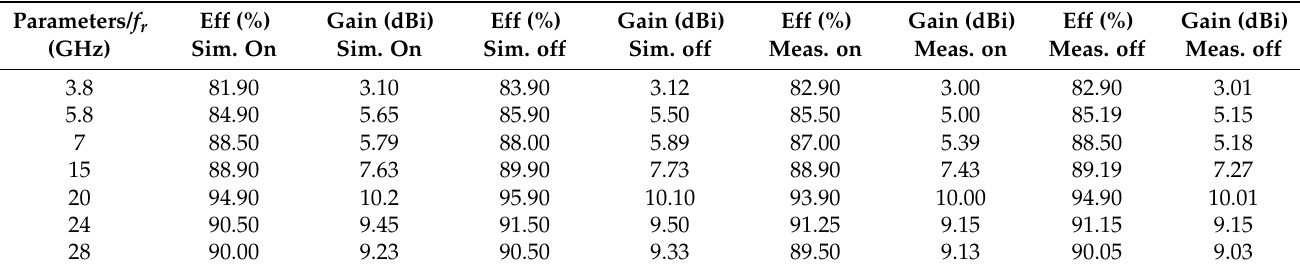
Figure 8. Simulated and measured gain and efficiency for both on-body (breast) and off-body (free space) conditions. Table 3. Proposed antenna’s gain (dBi) and efficiency (%) for simulation (sim) and measurement (meas) (on: on breast and off: free